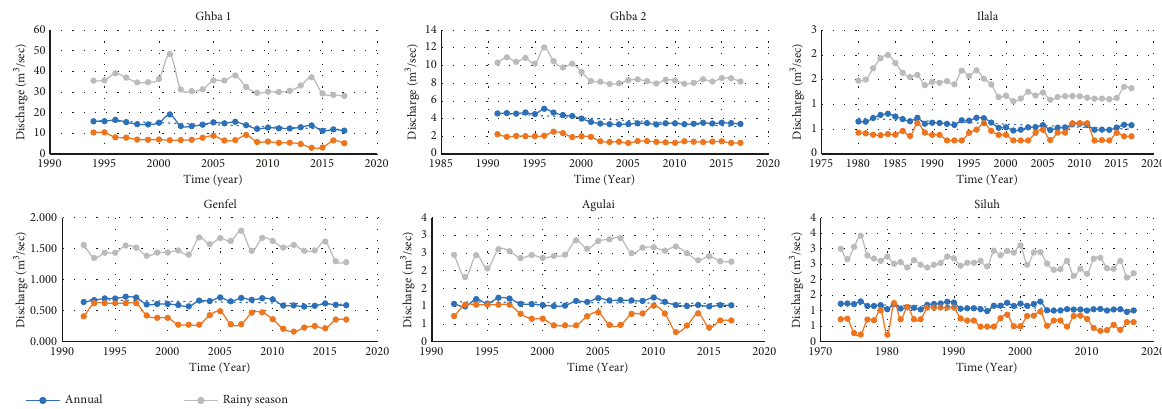
Figure 9: The temporal variability in the annual and seasonal streamflow in the